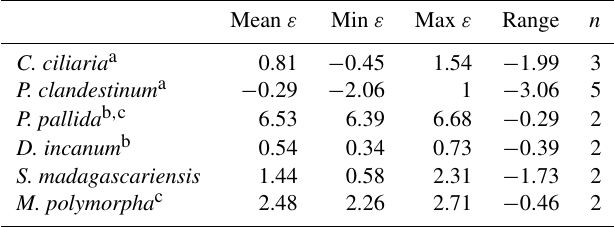
a Chlorophyll a and pyrochlorophyll a are combined.